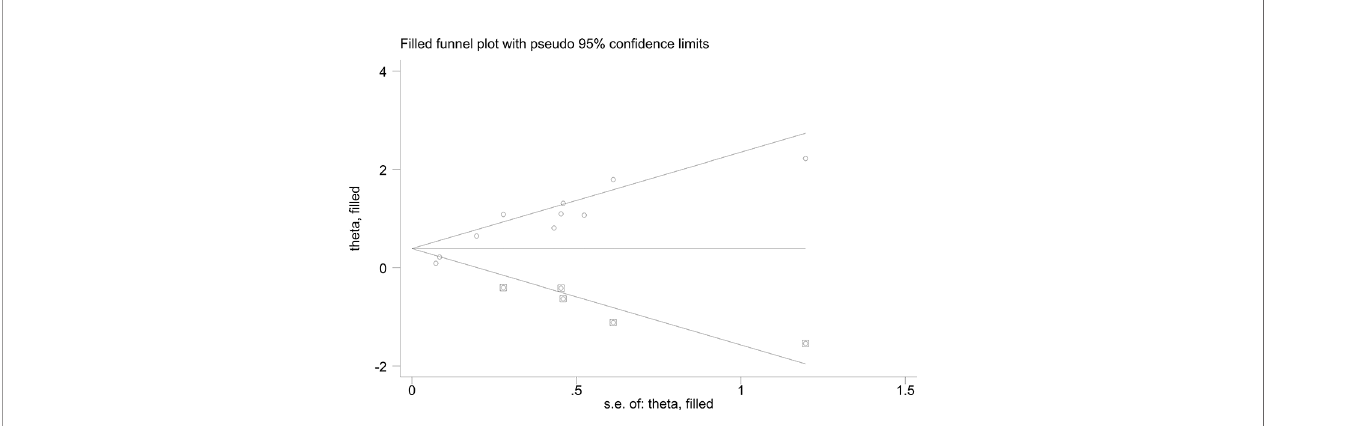
FIGURE 6 | Funnel plots of nonparametric trim-and- fi ll method about the elevated KL-6 level predicting mortality of